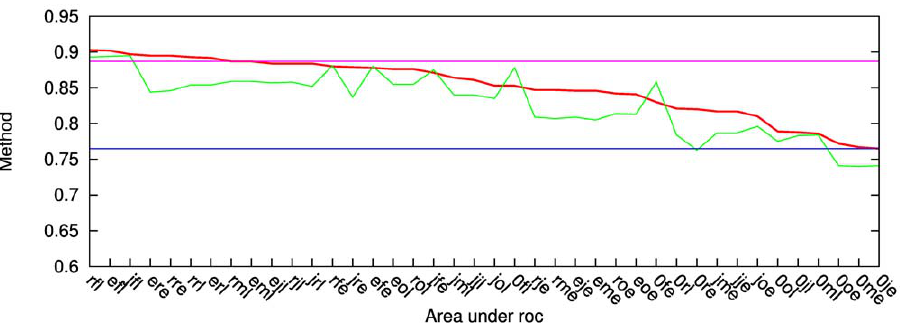
Figure 3. Combining various conservation and overlap scores into a single specificity scoring function for the LacI case. Method identifiers (see Methoda section and also Text S1): the first character: e: entropy, r: entropy modified by its expected value, j: Jensen-Shannon divergence from the stationary distribution, 0: no conservation score used. The second character: o: overlap of normalized distributions, f: squared difference, r: o modified by the expected value, m: pairwise mutual information. The third character: e: Euclidean distance, l: linear. Red: determinant model, green: discriminant. Pink: GroupSim, blue: mutual information. GroupSim uses conservation of neighboring residues as additional criterion. y-axis: area under the ROC curve for each method.